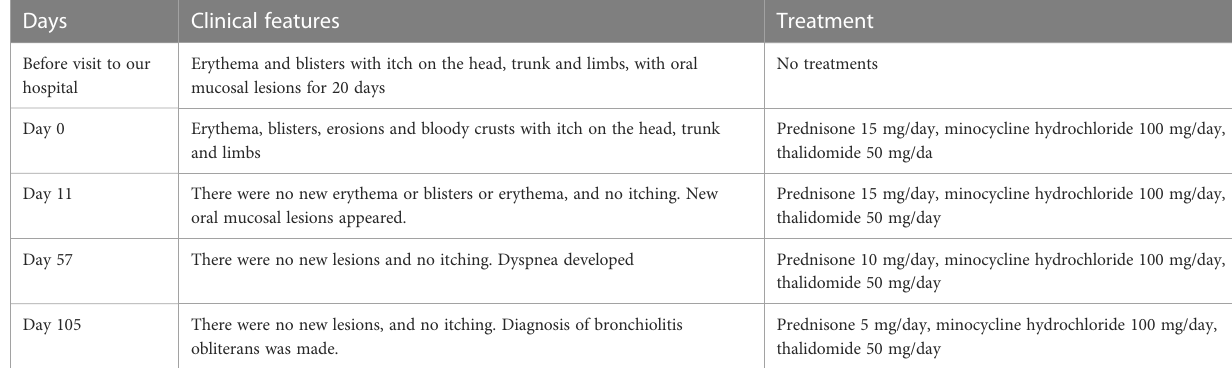
TABLE 1 Clinical features and treatment during the disease course. Days Clinical features